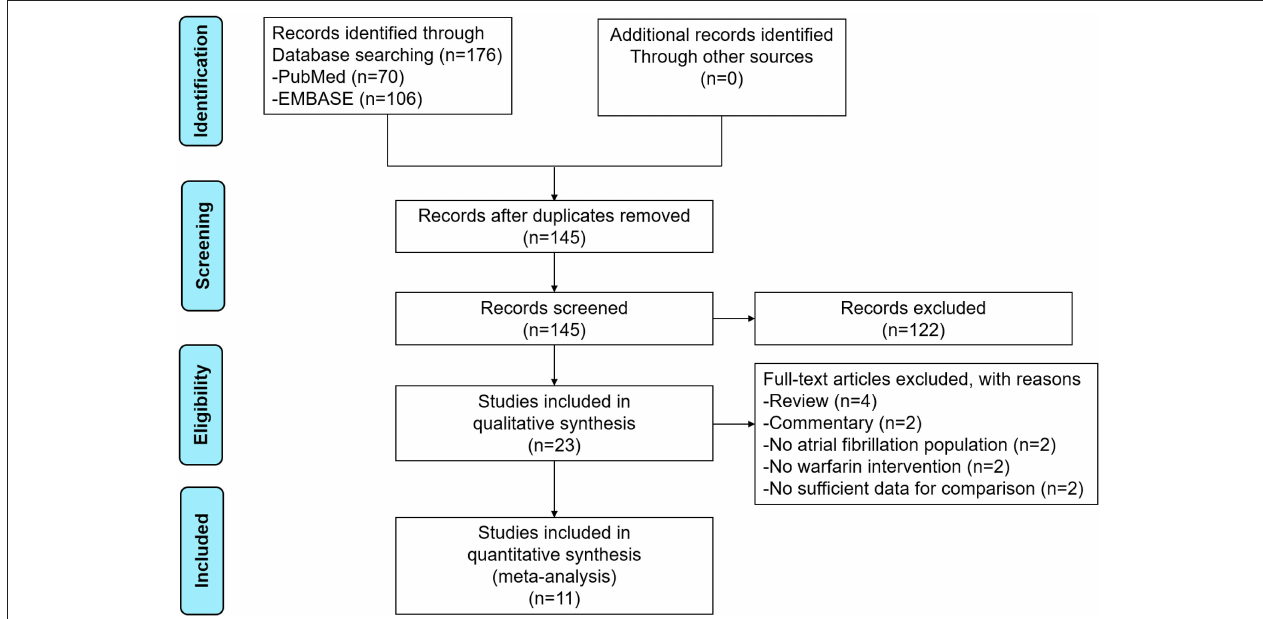
FIGURE 1 | The process of the literature retrieval of this meta-analysis.